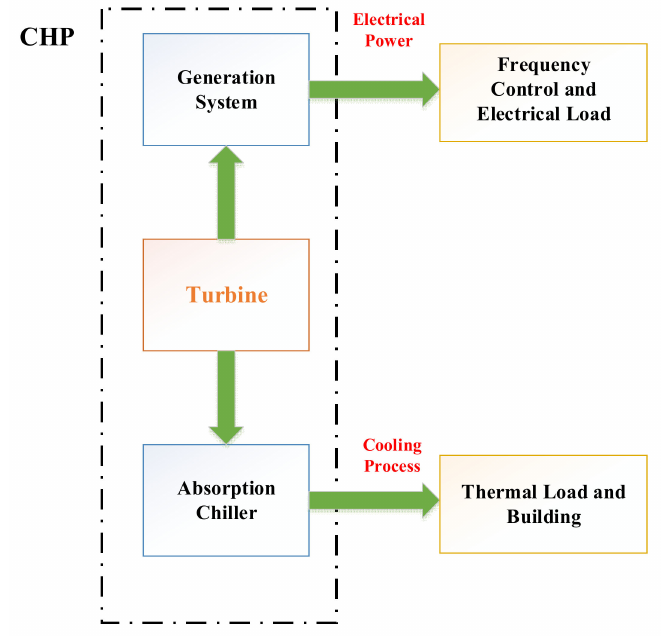
Figure 1. Overall layout of a combined heat and power (CHP)